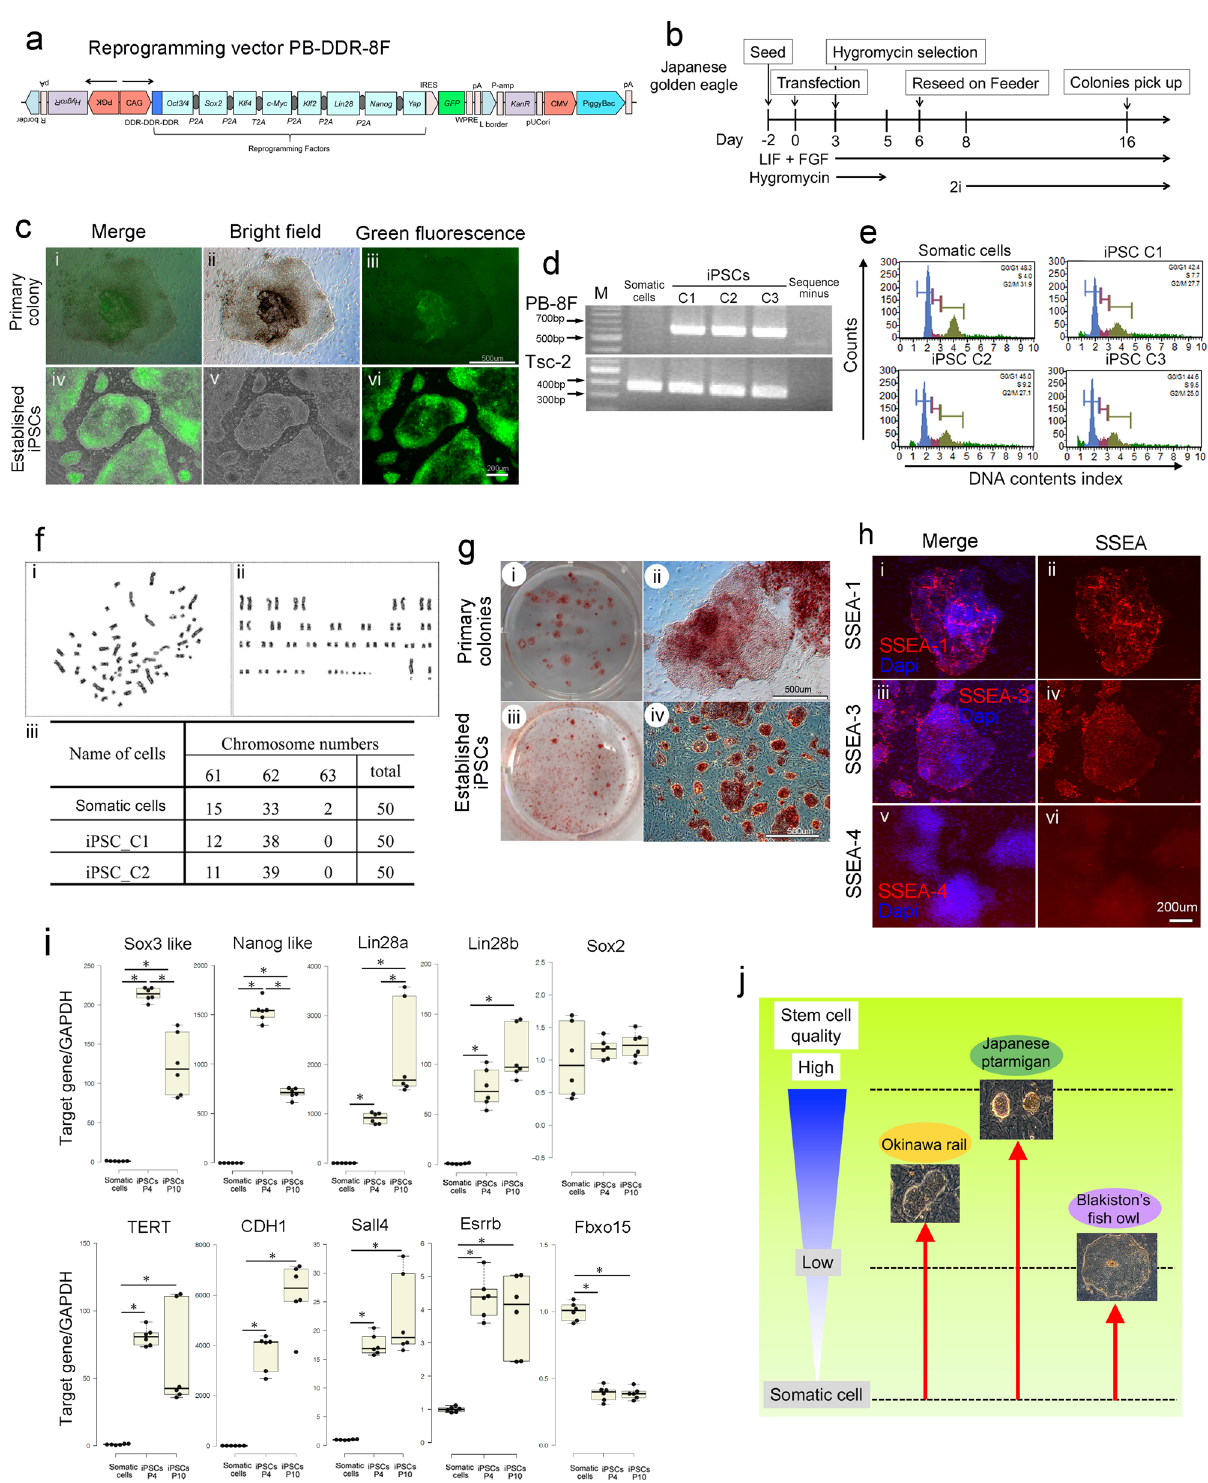
cells were fi xed in 4% paraformaldehyde in phosphate buffered saline (PBS) for 3 min. Cells were permeabilized by 0.5% Triton X-100 (35501-15; Nacalai Tesque, Kyoto, Japan) for 60 min. After three washes with PBS, the iPSCs were blocked with 1% bovine serum albumin (BSA, 01863-06; Nacalai Tesque) for 45min. iPSCs were incubated with a primary antibody overnight and then exposed to the cor- responding fl uorescent-labeled secondary antibodies for 60 min. Counterstaining was performed with a 4 ′ ,6-diamidino-2-phenylindole (DAPI) solution (Cellstain- DAPI solution, DOJINDO, Kumamoto, Japan). Japanese golden eagle and chicken-derived fi broblasts were seeded in 12-well cell culture plates for immunological staining. After 48 h of incubation, F-actin